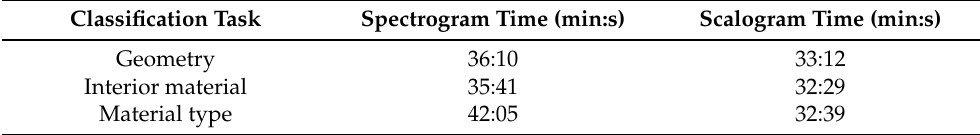
Table 8. Hyperparameter optimization time for networks trained on data with 20 dB